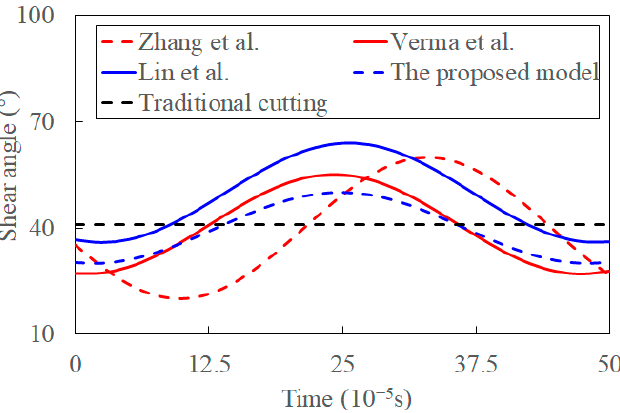
Figure 13. The evolution of shear angle in chip formation process (h = 0.005 mm, hv = 8 um, n = 652 r/min, θ = 36 ◦ , D r = 12